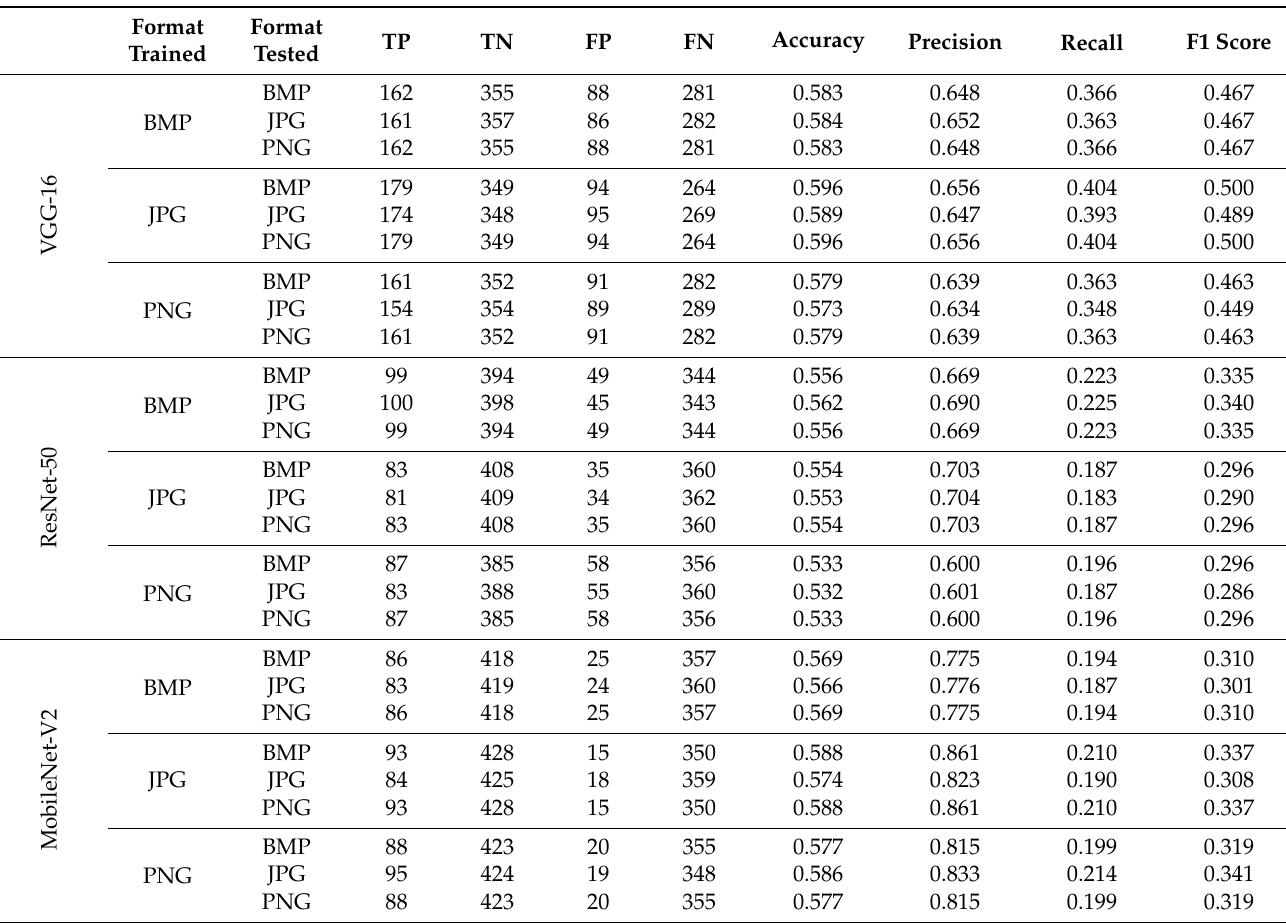
Table 4. Experimental results of small dataset trained 400 epochs models when evaluated by common file